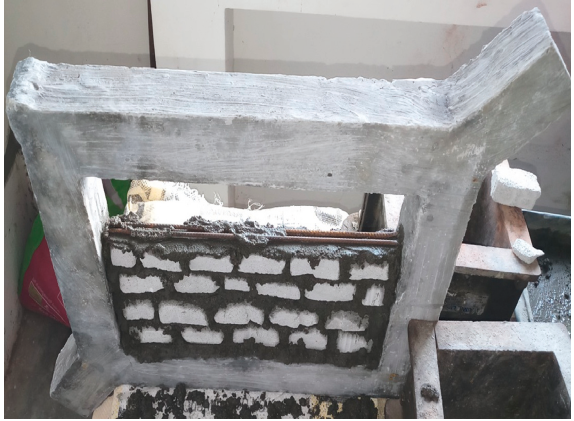
Figure 3: Casting of the infilled RC frame.